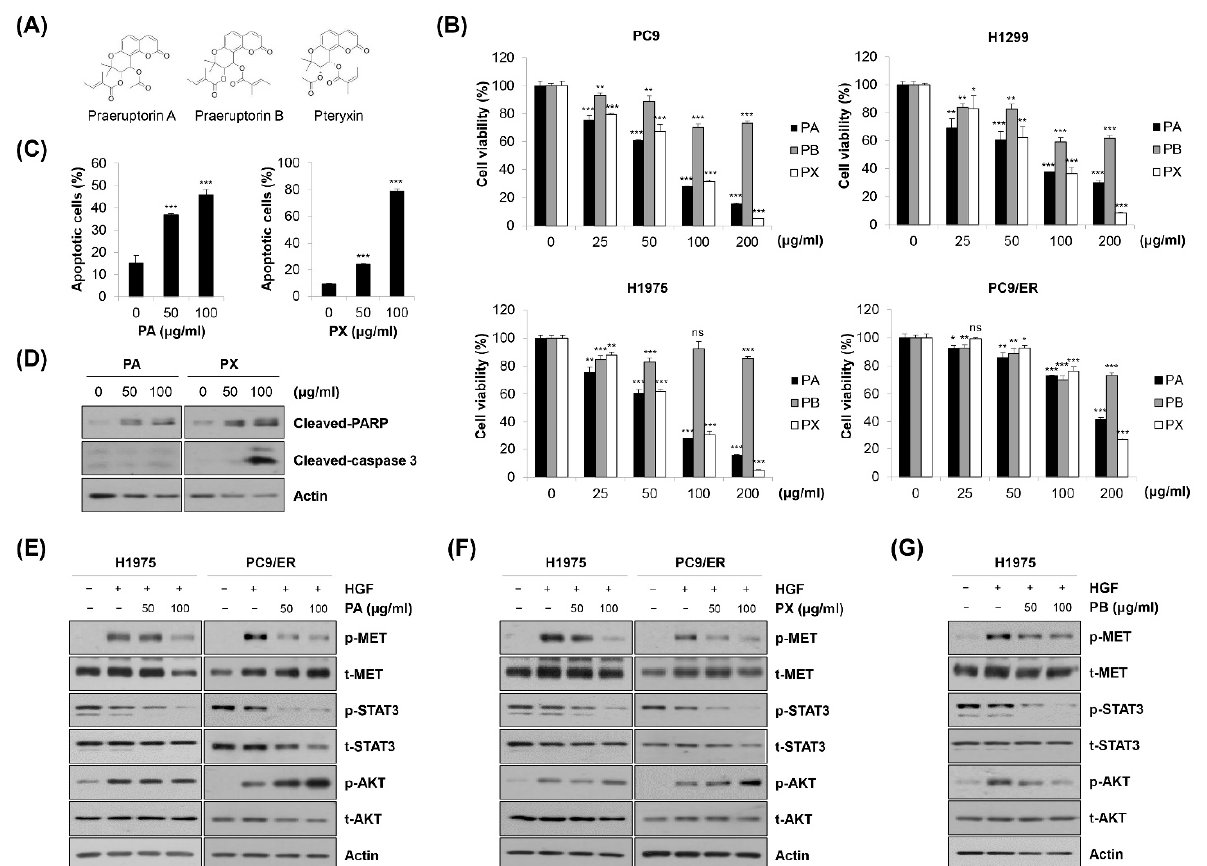
Figure 6. Identification of specific compounds contributing to the anticancer effect of EPP. ( A ) The chemical structures of praeruptorin A (PA), praeruptorin B (PB), and pteryxin (PX) are shown. ( B ) PC9, H1299, H1975, and PC9/ER human NSCLC cells were treated with PA, PB, and PX for 72 h. Cell viability was evaluated using the MTT assay. ( C , D ) H1975 cells were treated with either PA or PX for 72 h. ( C ) The percentage of annexin V-positive cells was evaluated via flow cytometry. Significance was determined using Student’s t -test (ns, not significant; * p < 0.05, ** p < 0.01, *** p < 0.001 vs. untreated control). ( D ) The expression of cleaved caspase-3 and cleaved PAPR was assessed via Western blot analysis. ( E , F ) H1975 and PC9 cells were pretreated with either PA ( E ) or PX ( F ) for 24 h and stimulated with HGF (20 ng/mL) 30 min before harvest. ( G ) H1975 cells were pretreated with PB for 24 h and stimulated with HGF (20 ng/mL) 30 min before harvest. ( E – G ) Phosphorylated and total MET, AKT, and STAT3 proteins were detected using Western blot analysis. Actin was used as the internal control. Representative images of duplicate experiments are shown. NSCLC, non-small-cell lung cancer; HGF, hepatocyte growth factor; STAT3, signal transducer and activator of transcription